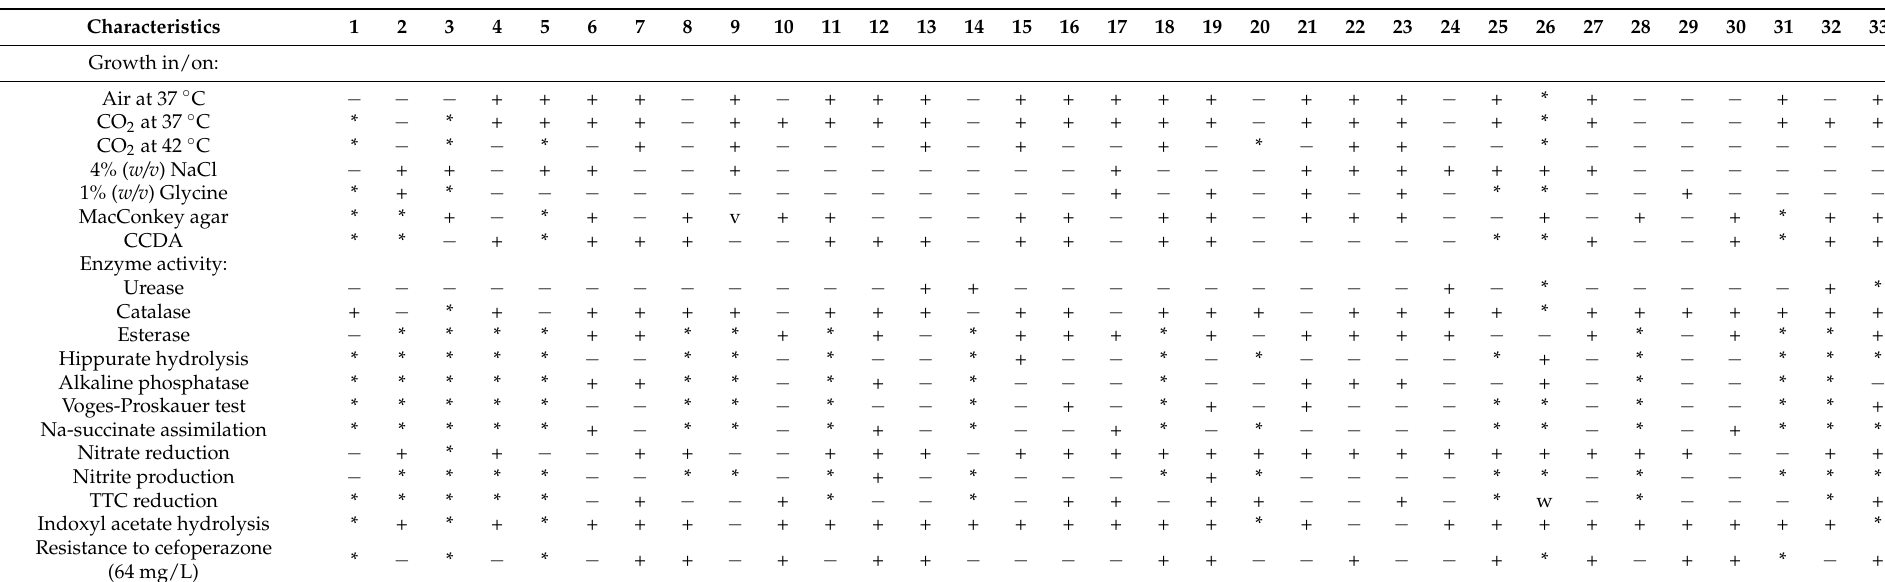
Table 2. Differential physiological characteristics of all identified genus Arcobacter